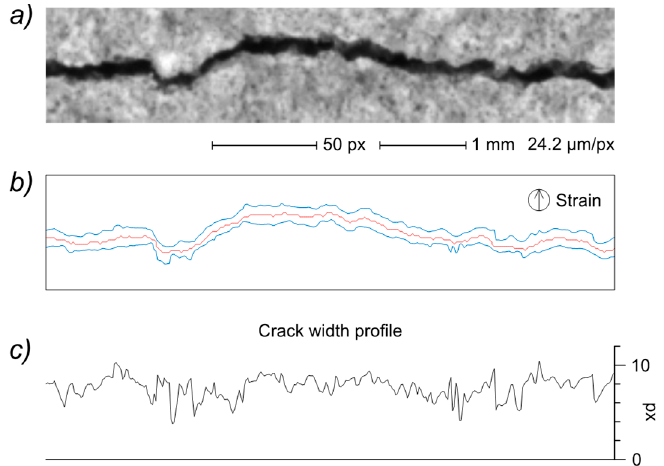
Figure 14. Crack width profile (detail) computed on a crack image by EG guidance. Original crack image ( a ); crack EG (red), computed crack edge (blue) and strain direction ( b ); crack width profile computed along the strain direction with parallel measuring lines ( c